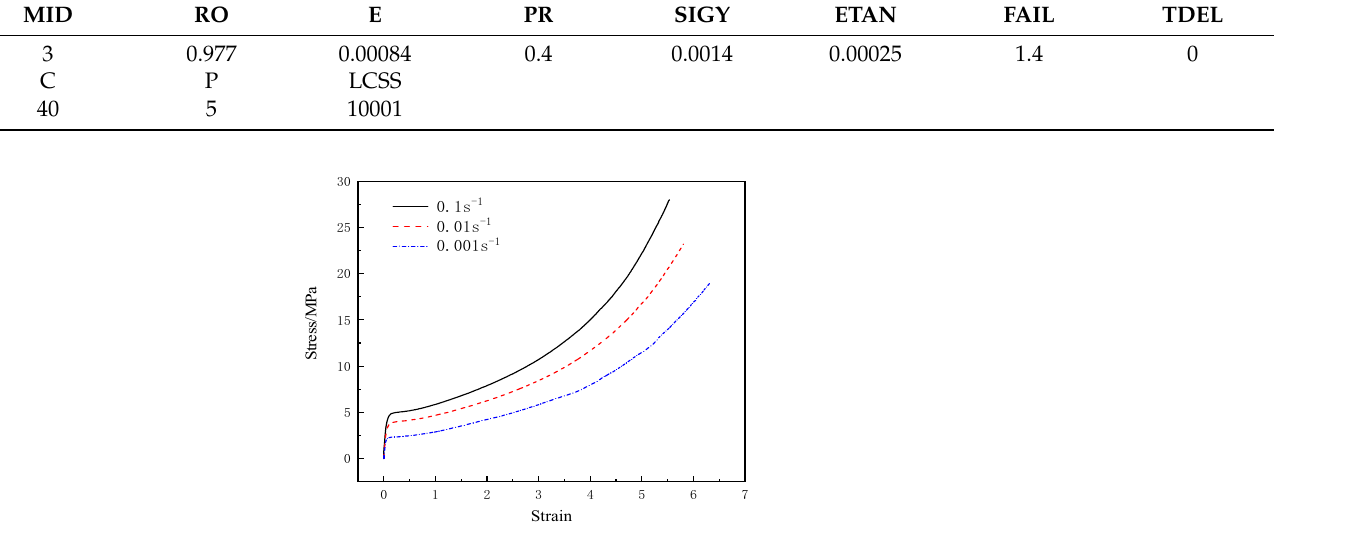
Figure 6. T26 polyurea stress–strain curve at a low strain rate.